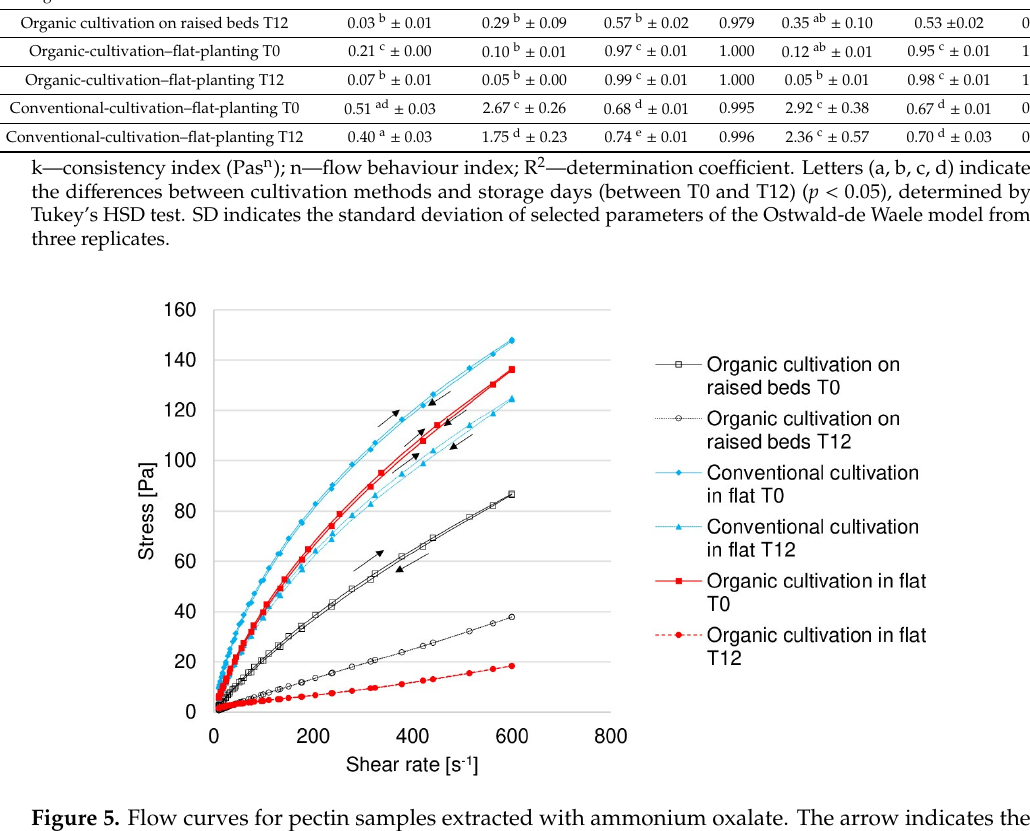
Figure 5. Flow curves for pectin samples extracted with ammonium oxalate. The arrow indicates the direction of the line. T0—harvest day, T12—last day of the experiment.